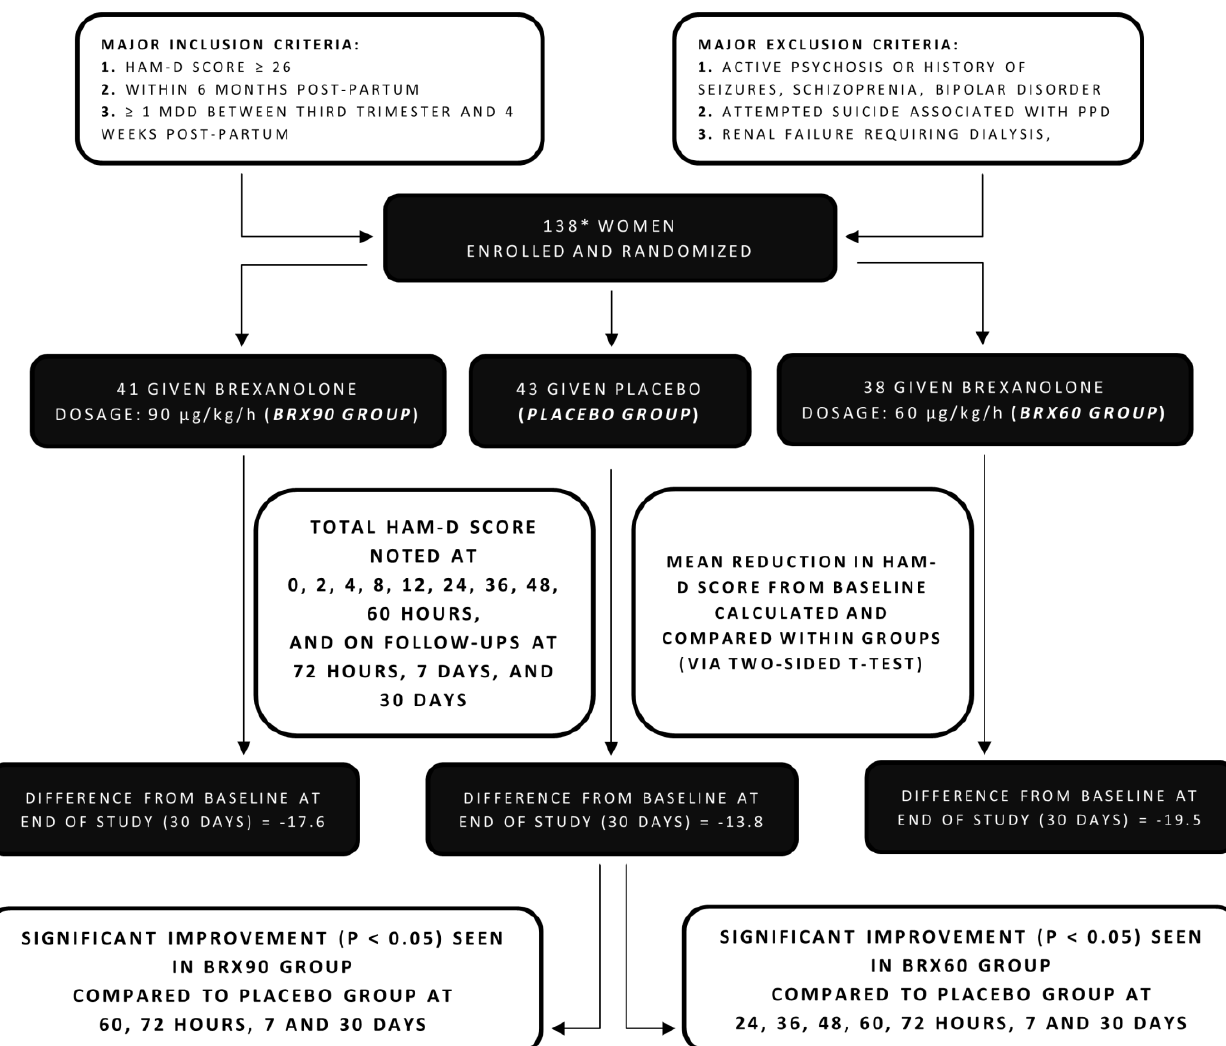
Figure 2. Flowchart summarizing methods and findings of randomized controlled trial (study 1) by Meltzer-Brody et al. 2018 . * 138 participants were enrolled, of which 16 were not included in analysis for various reasons [14].